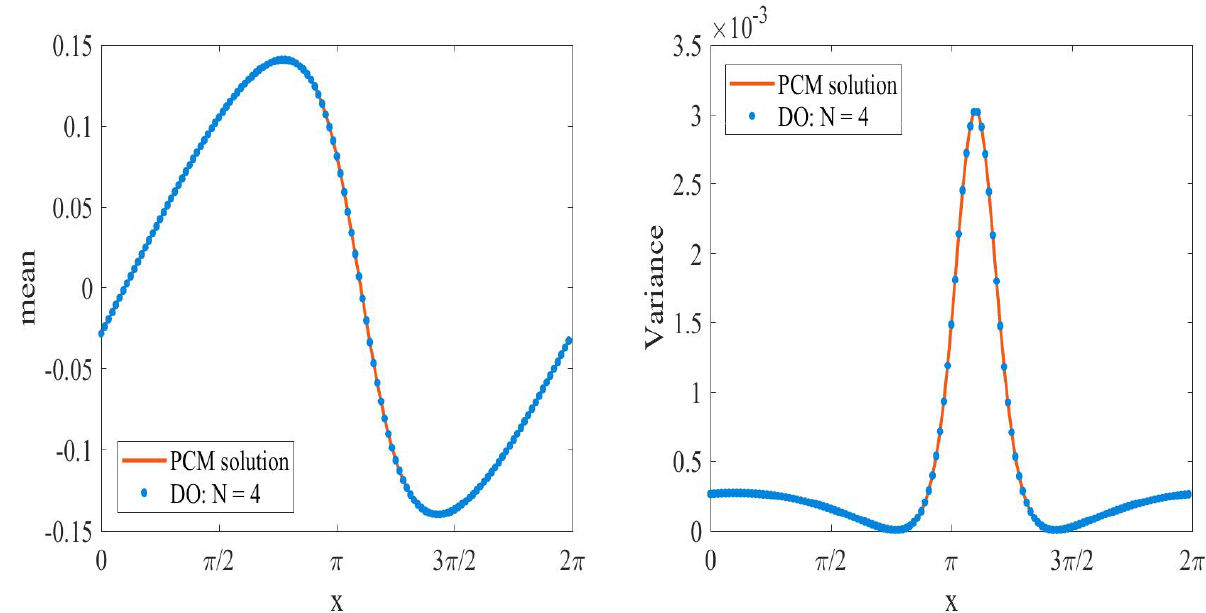
error ( left ) and variance error ( right ) for the inviscid Burgers’ equation at Figure 7. Mean and switching time with the number of modes .       =    =   =